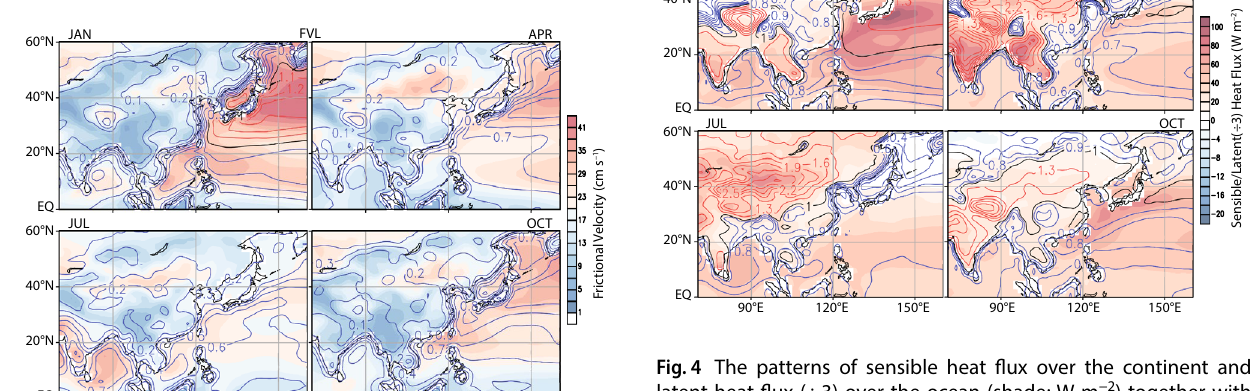
Fig. 4 The patterns of sensible heat flux over the continent and latent heat flux (÷ 3) over the ocean (shade; W m −2 ) together with the maximum boundary layer height (blue contour lines at 0.1 km interval < 1.0 (black) < red contour lines at 0.3 km interval) for the diurnal/seasonal cycle mode. Latent heat flux is divided by 3 so that both the patterns of sensible heat flux over the continent and those of latent heat flux over the ocean have sufficient numbers of color